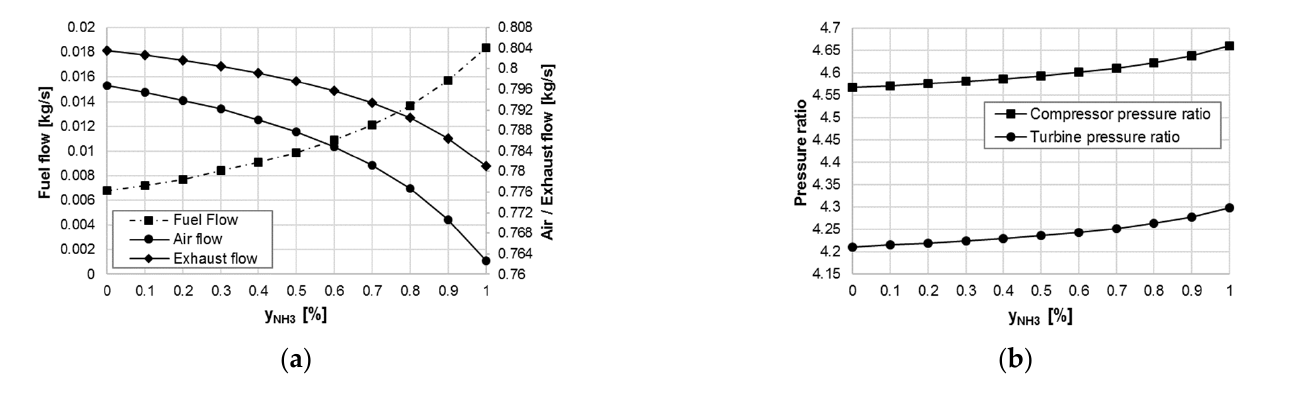
Figure 7. Effects of increasing ammonia blending ratio (y NH3 ) on: ( a ) fuel input and thermal power; ( b ) thermal end electric efficiency.